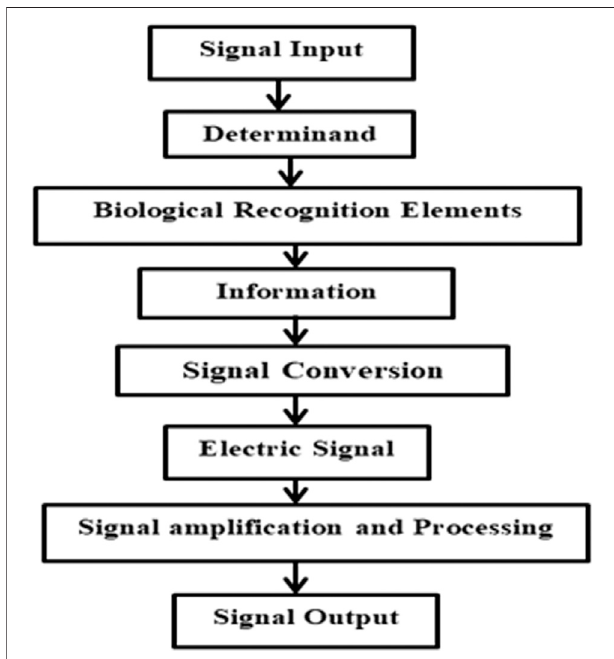
FIGURE 1 | Schematic of sensing by